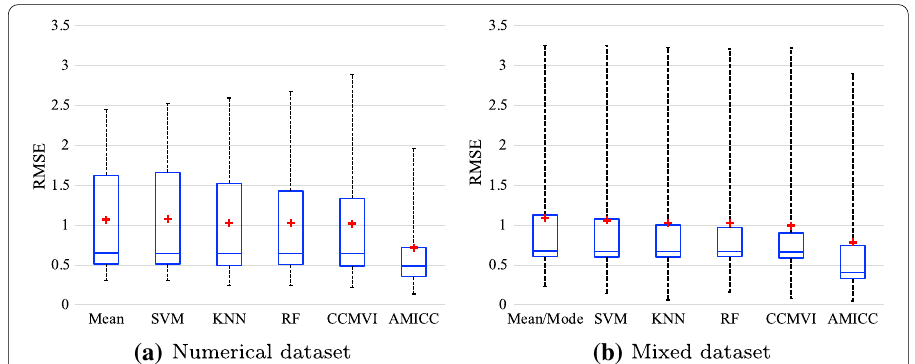
Fig. 16 Boxplots of the average RMSE values for the MVI methods on ( a ) the numerical, and ( b ) the mixed